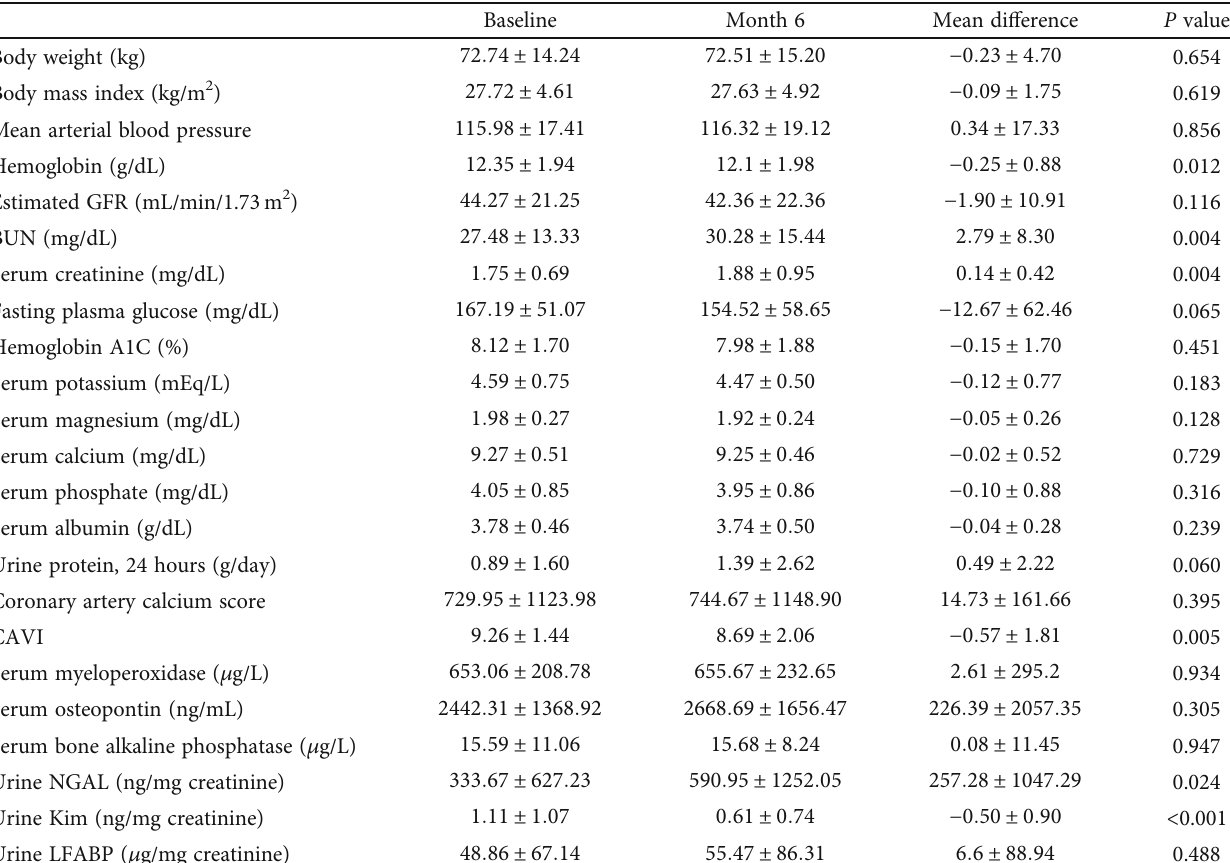
Table 3: Changes in clinical characteristics and laboratory indices in the control group from baseline to month